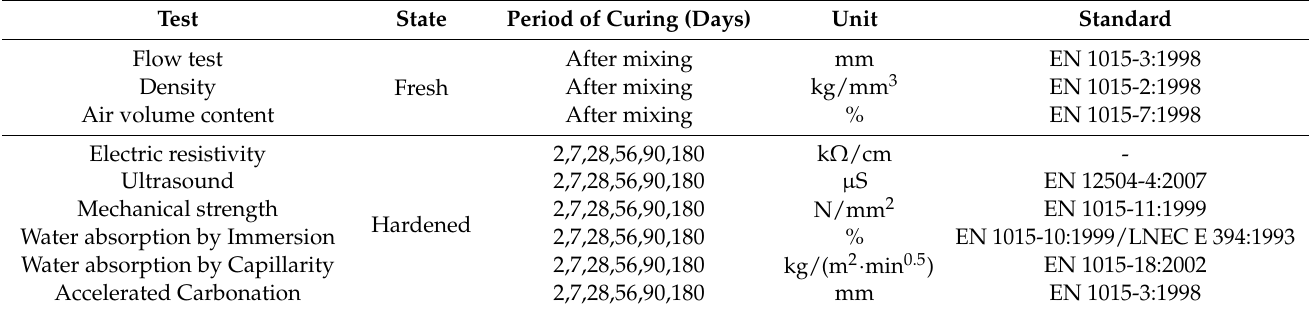
Table 3. Tests carried out in mortars in the fresh and hardened